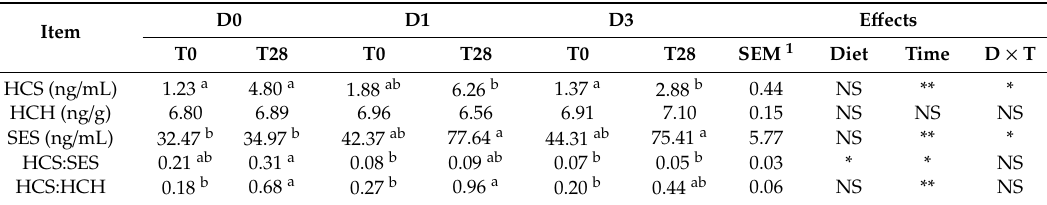
Table 2. Mean concentrations of cortisol (HCS) and serotonin (SES) in saliva and cortisol in hair (HCH) of dogs fed diet without supplementation of grape proanthocyanidins (D0) or supplemented with 1 mg / kg live weight (D1) or 3 mg / kg live weight (D3) of grape proanthocyanidins at the beginning of the study (T0) and after 28 (T28) days of